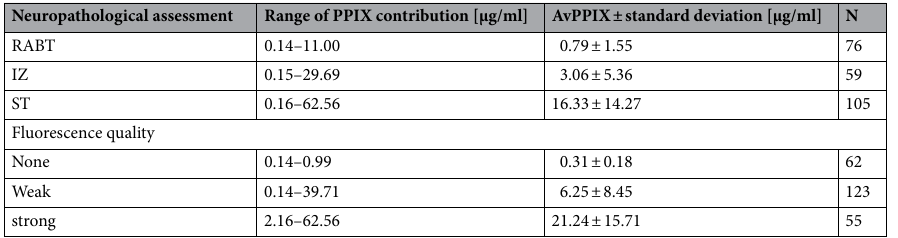
Neuropathological assessment